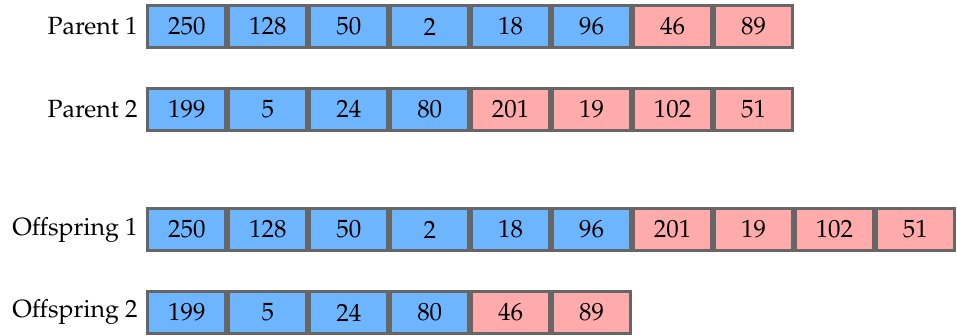
Figure 1. Example of two individuals being operated by one-point